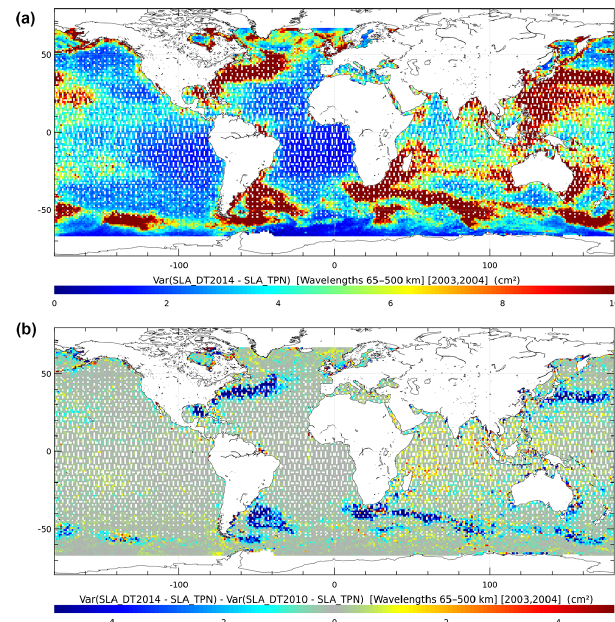
Figure 11. (a) Variance of the differences between gridded DT2014 two-sat-merged SLA and independent TP-interleaved along-track SLA measurements. Statistics are presented for wavelengths rang- ing from 65 to 500km. (unit: cm 2 ). (b) Differences with the results obtained with the DT2010 SLA products. Negative values indicate a reduction of the differences between gridded and along-track SLA when DT2014 products are considered.